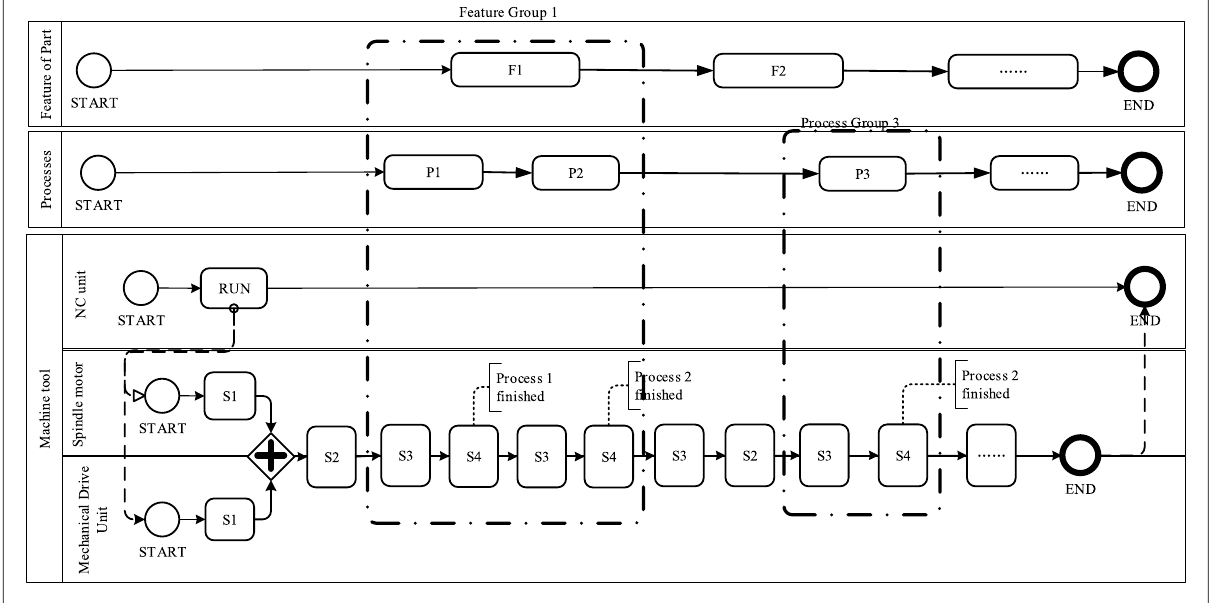
Figure 5 The relationship of machine tools, parts, and processes with BPMN